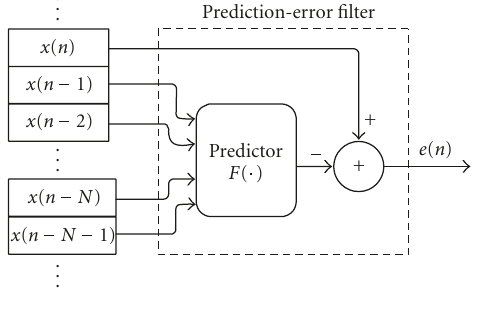
Figure 1: Prediction-error